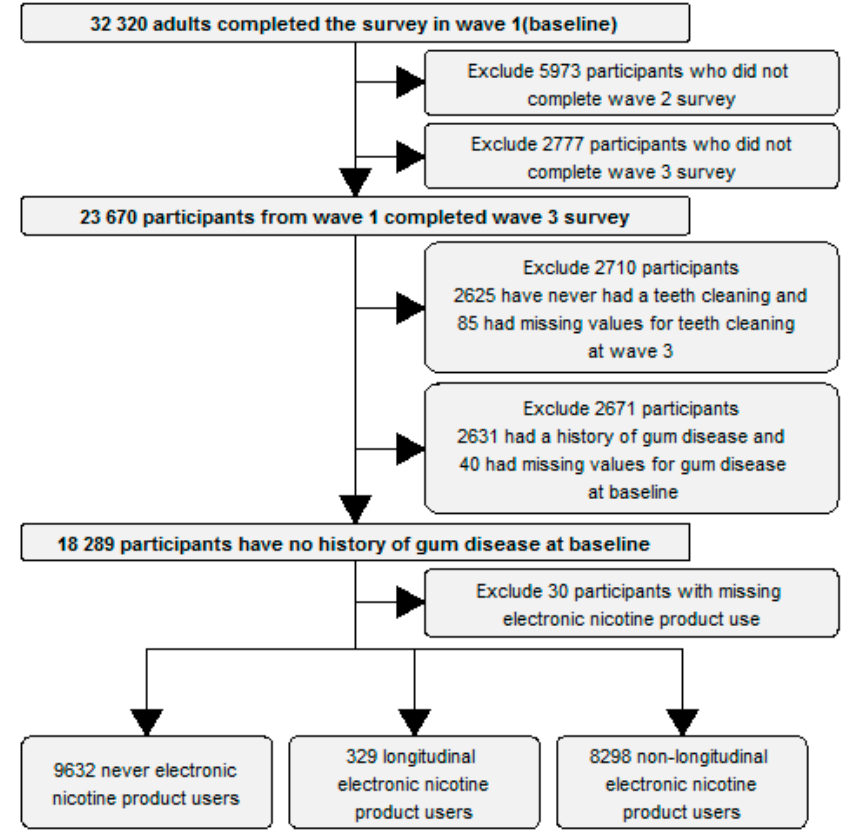
Figure 1. Flow chart showing selection criteria .